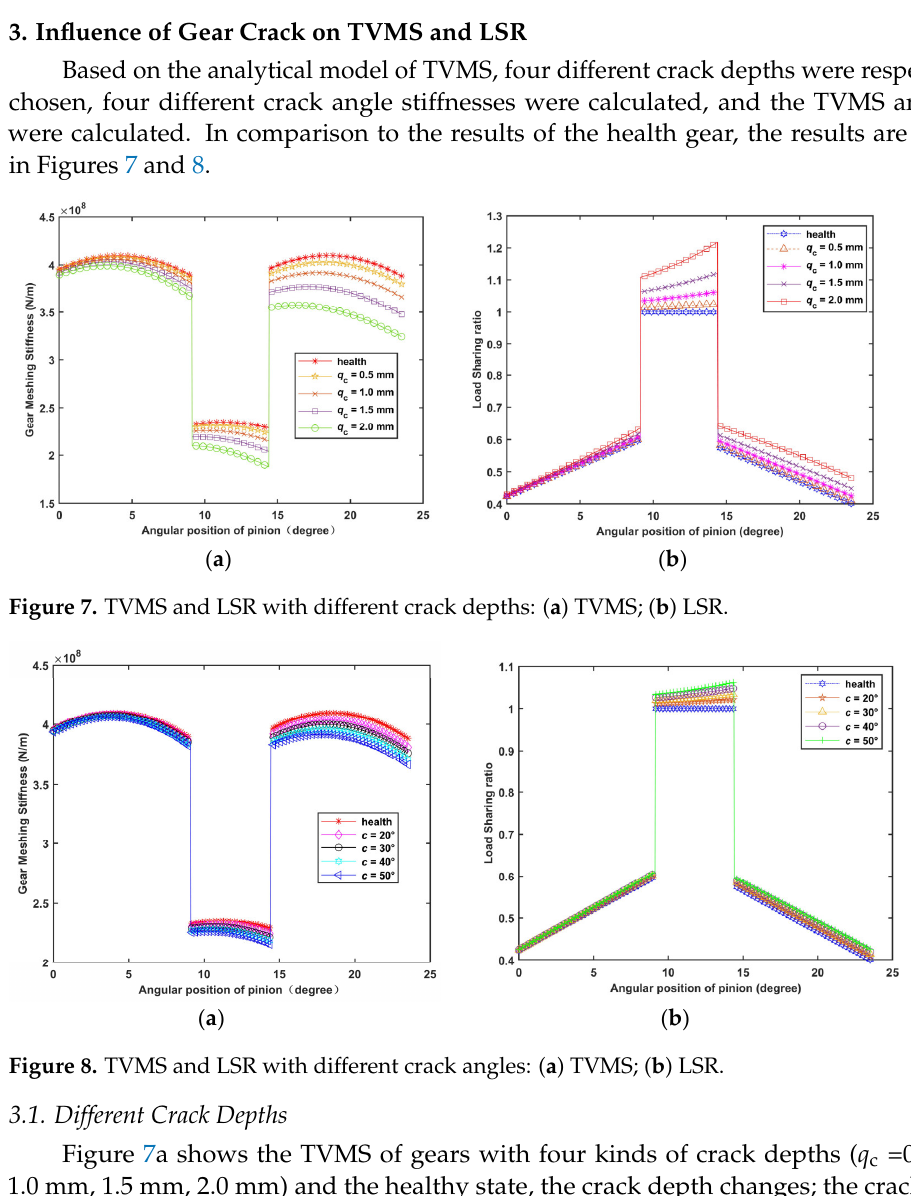
Figure 8. TVMS and LSR with different crack angles: ( a ) TVMS; ( b ) LSR.